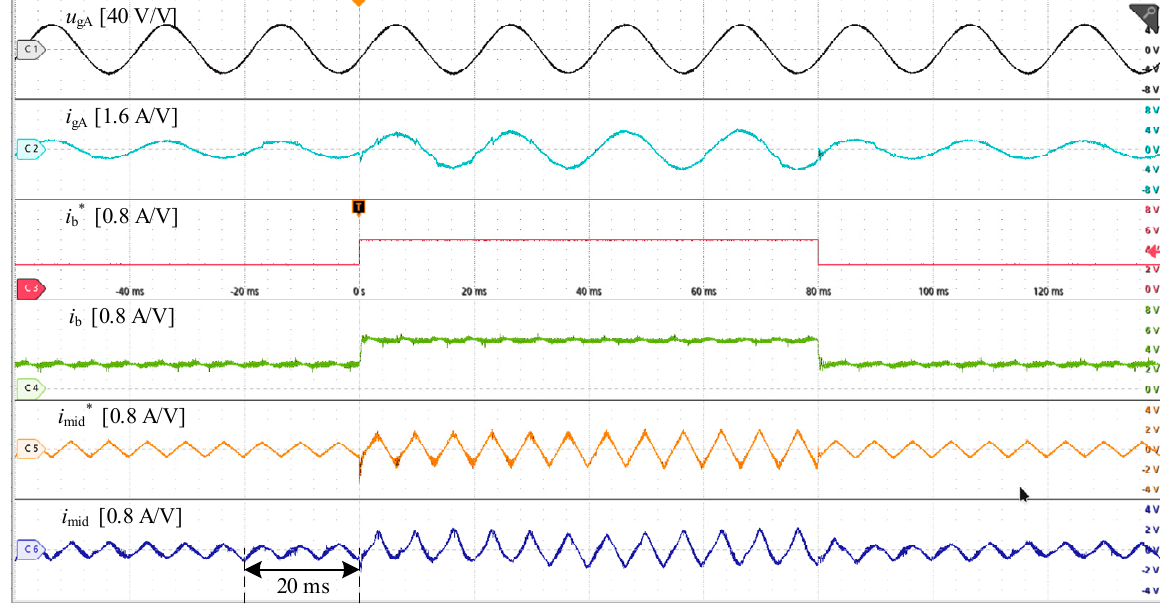
Figure 12. Experimental results of H3C-BESS in CP mode.